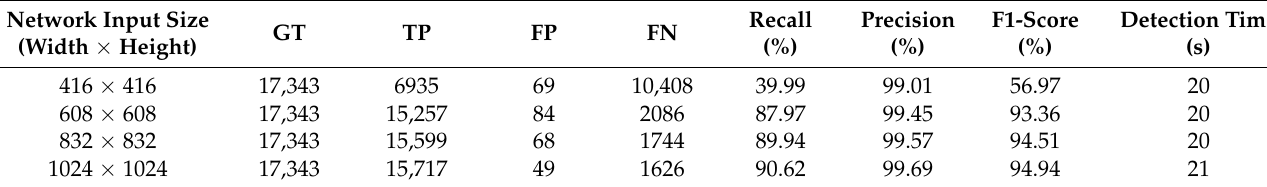
Figure 9. Comparison of the recall values of YOLOv3, YOLOv4, and YOLOv5m. The poor training on the network input size 1024 × 1024 YOLOv4 is shown in Table S2 Supplementary Spreadsheet 1 ; there is a downward trend in the precision, F1-score, and average IoU values in the 2500 to 6000 iterations. This can also be seen in the compar- ison of the average IoU values in the training validation, as shown in Figure 10. YOLOv3 and YOLOv5m have an upward trend for the network input sizes 416 × 416, 608 × 608, 832 × 832, and 1024 × 1024, while YOLOv4 has an uptrend for the network input sizes 416 × 416, 608 × 608, and 832 × 832 but a downward trend at 1024 × 1024. This is also in line with the F1-score values. YOLOv4 has an upward trend with val- ues above 90% for the network input sizes 416 × 416, 608 × 608, and 832 × 832 but a down- ward trend in the network input size 1024 × 1024, with a value of 76.29%. YOLOv3 has a stable value at over 90% for the network input sizes 416 × 416, 608 × 608, 832 × 832, and 1024 × 1024, and YOLOv5m has an uptrend for the network input sizes 416 × 416, 608 × 608, 832 × 832, and 1024 × 1024. The low value of the F1-score on the network input sizes 1024 × 1024 YOLOv4 and 416 × 416 YOLOv5m is due to the low recall value. The compar- ison of the F1-score values of YOLOv3, YOLOv4, and YOLOv5m can be seen in Figure 11.